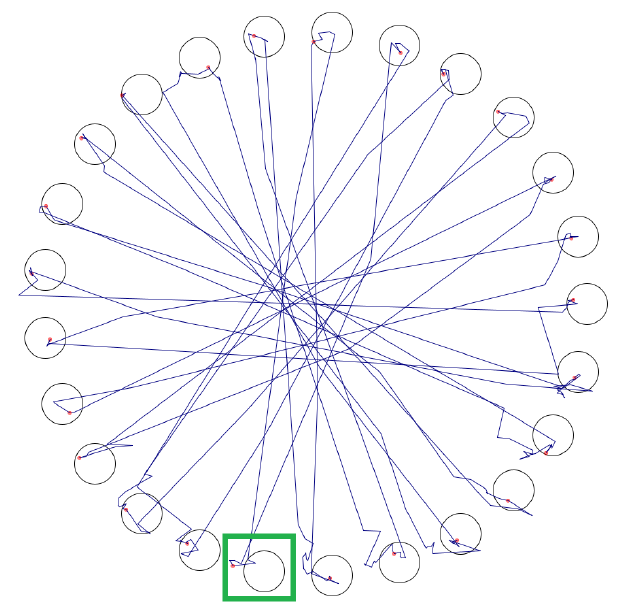
Figure 6. Example of the path of the mouse cursor taken by the subject during the task, green rectangle = target which is rated as